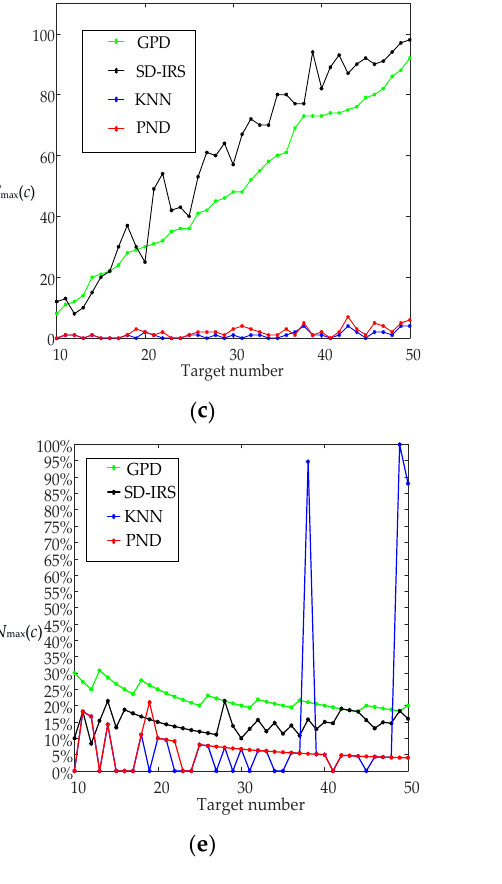
Figure 4. Scenario 2: different target numbers and different movement forms. ( a ) Ez ( c ) comparison of different algorithms under the condition of uniform linear motion of targets; ( b ) Ez ( c ) comparison of different algorithms in the case of target turning at constant speed; ( c ) F max ( c ) comparison of different algorithms under the condition of uniform linear motion of targets; ( d ) F max ( c ) comparison of different algorithms in the case of target turning at constant speed; ( e ) N max ( c ) comparison of different algorithms under the condition of uniform linear motion of targets; ( f ) N max ( c ) comparison of different algorithms in the case of target turning at constant speed.